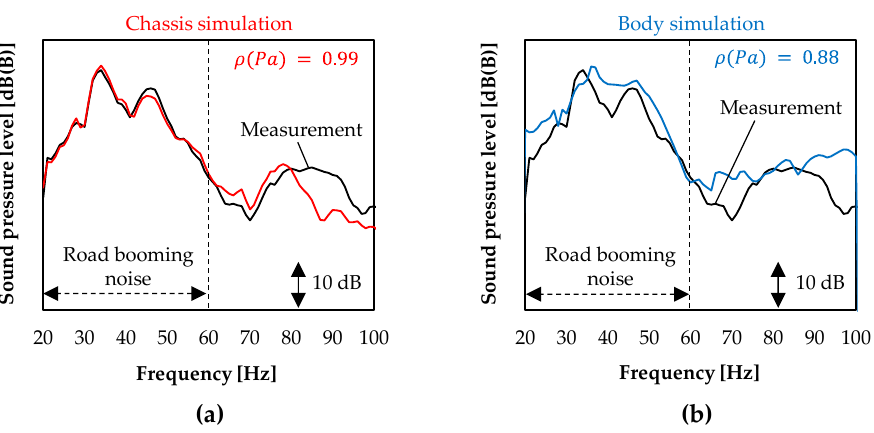
Figure 5. Calculated sound pressure level of a vehicle for driving on a rough road (test track, non- uniform road profile at 40 km/h): ( a ) Chassis simulation compared to the measurement; ( b ) Body simulation compared to the measurement.